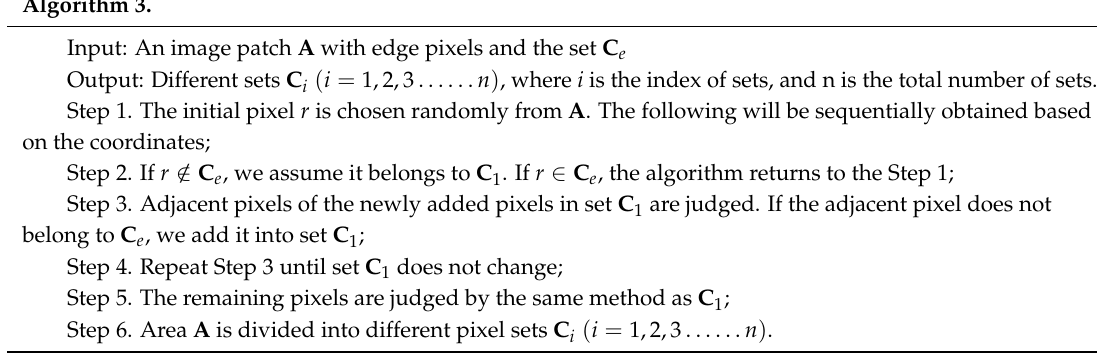
Figure 3. Some special forms of the edge curves. Algorithm